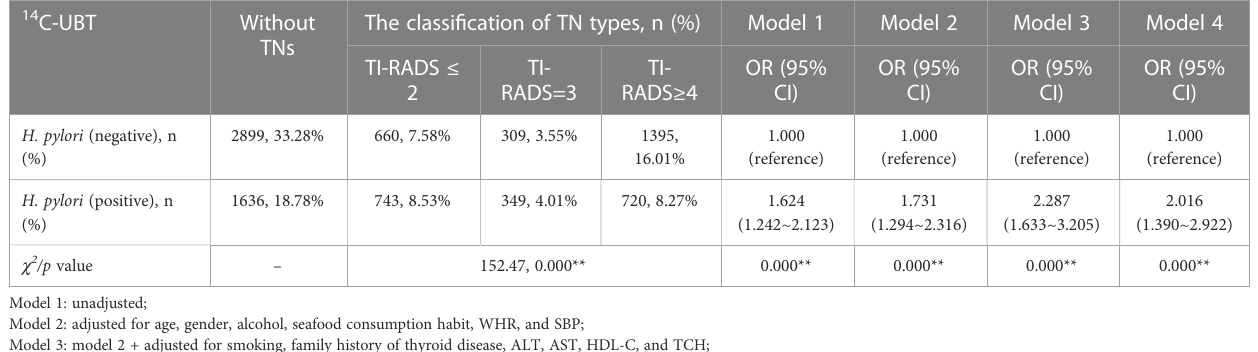
Model 3: model 2 + adjusted for smoking, family history of thyroid disease, ALT, AST, HDL-C, and TCH; Model 4: model 3 + adjusted for BMI, DBP, FT3, FT4, anti-TPO, Tg, and